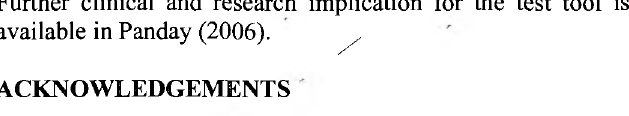
Table 3: Test statistic for the Kendall’s Co-efficient of Concordance for familiarity, phonetic dissimilarity and